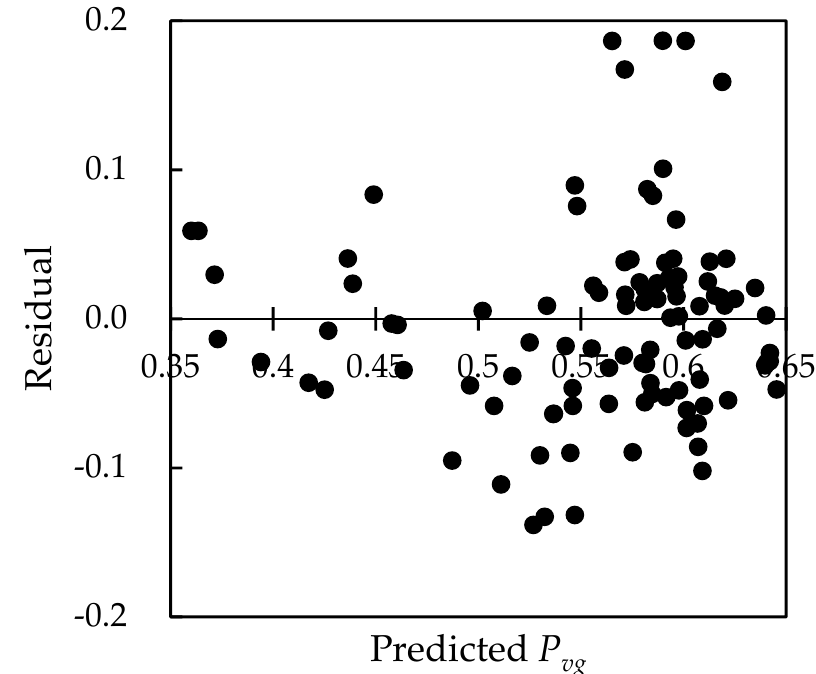
Figure 14. The residual plot of the estimated P vg and LAI.